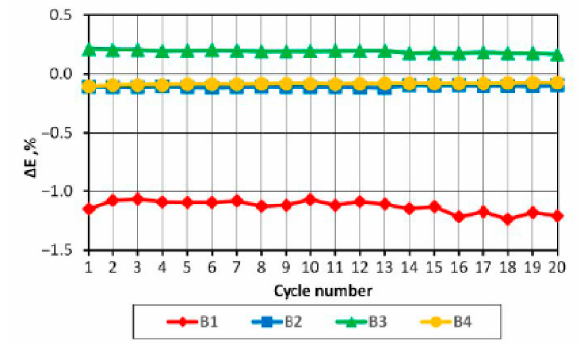
Figure 7. Differences in energy supplied from the battery in successive charging cycles calculated in accordance with the Formula (10).